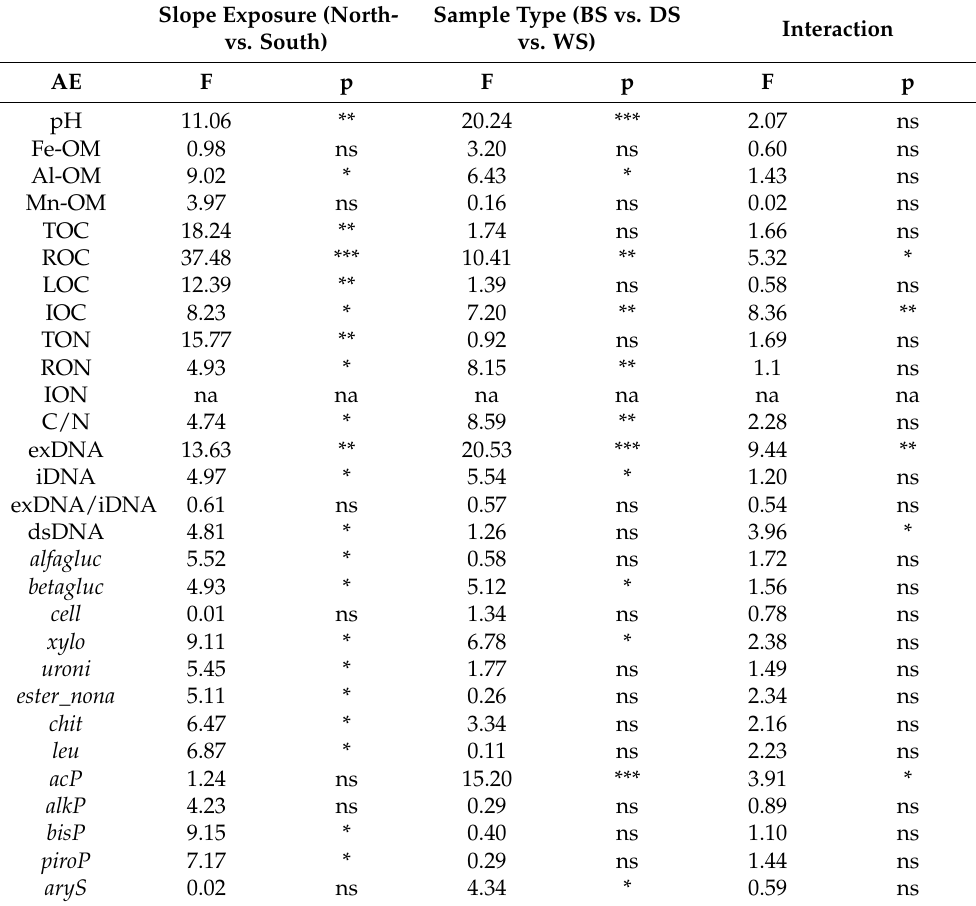
Table 6. Statistical output of the physico-chemical and microbiological parameters as a function of slope exposure (north- vs. south-facing sites) and between bulk soil (BS) and aggregate sizes fractions (dry-sieved [DS] and water-stable [WS] 1.00–0.50 mm) in the mineral (AE) horizon. Slope Exposure (North- vs.